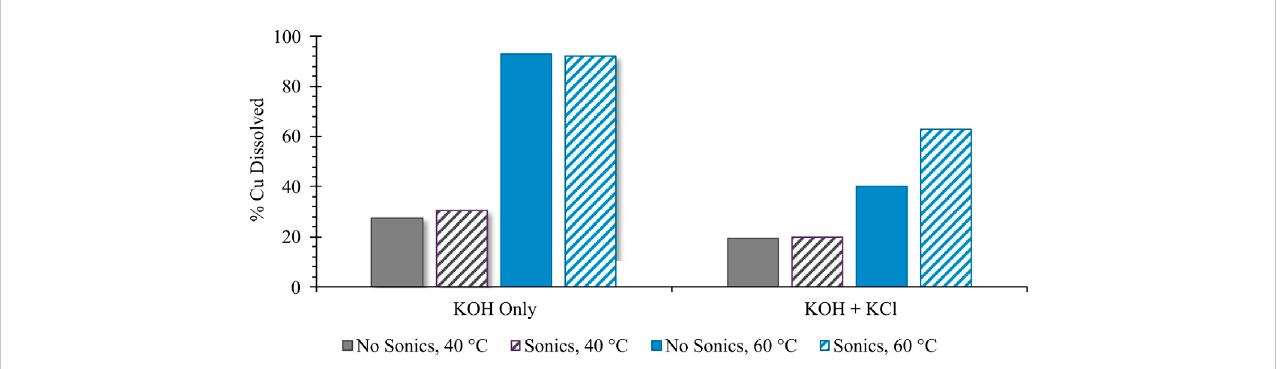
FIGURE 2 Impact of sonication, temperature, and presence of Cl − salt on extent of Cu 0 corrosion, reported as the percentage of initial Cu added dissolved in solution. All samples were analyzed using the reported colorimetric titration technique after 2 h of stirring time under ambient atmospheric oxygenation conditions.